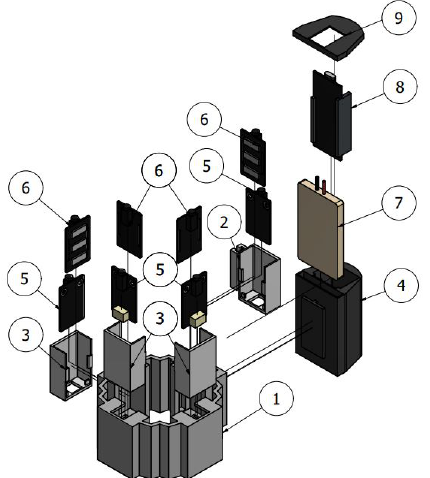
Figure 3. Structural design and elements integrating the WyoFlex band. (1) Flexible band, (2 and 3) Sensor case, (4) Control system case, (5 and 6) EMG sensor, (7) Battery, (8) FireBeetle-E microcontroller, (9) Control system